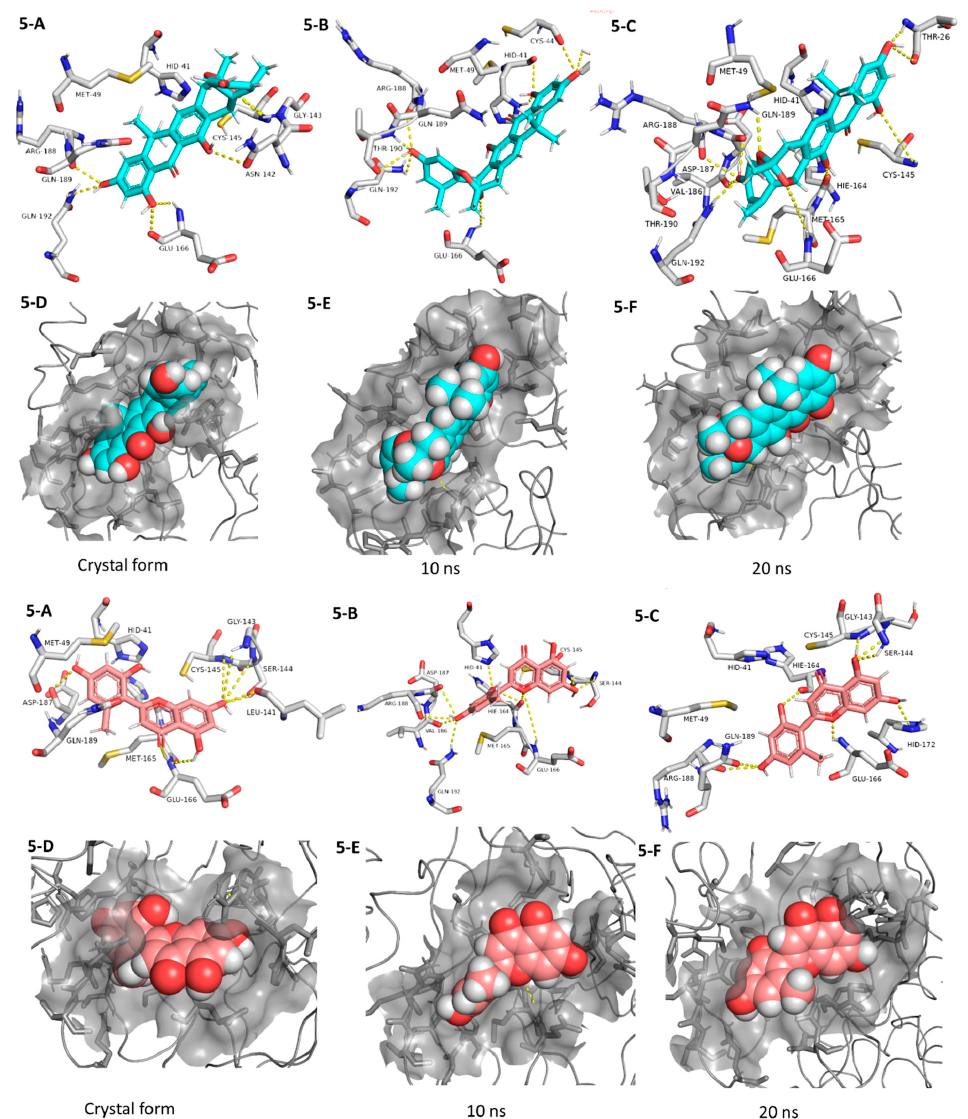
Figure 7. Interactions and binding modes of compounds 5 and 6 (Blue and red molecules, respectively) inside the M pro active site in the crystal form and during MDS ( 5-A – 6-F